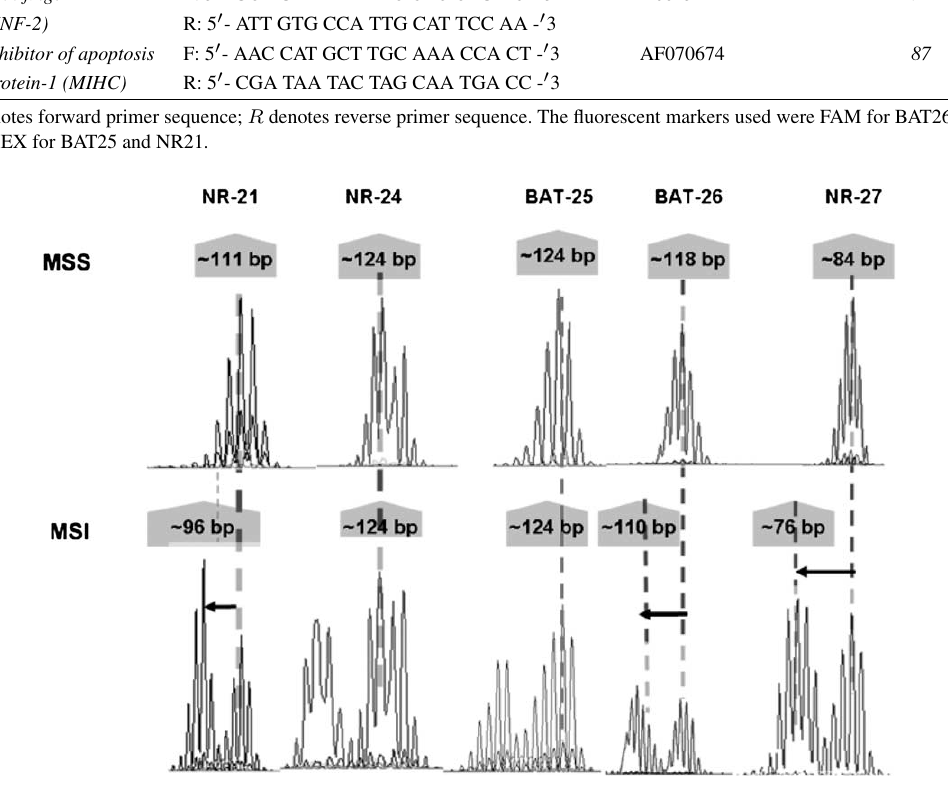
Fig. 1. MSI analysis electropherogram of the 5 markers used. Typical allelic profiles for the different markers. Top line shows microsatellite stable (MSS) tumors; bottom line shows tumors with microsatellite instability (MSI) displaying changes in product size (two peaks) with a shift, typically of about 10 bp length (bp denotes base